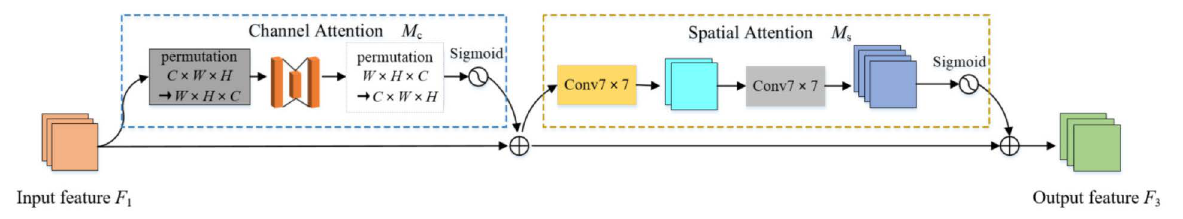
Figure 5. The construction of the GAM